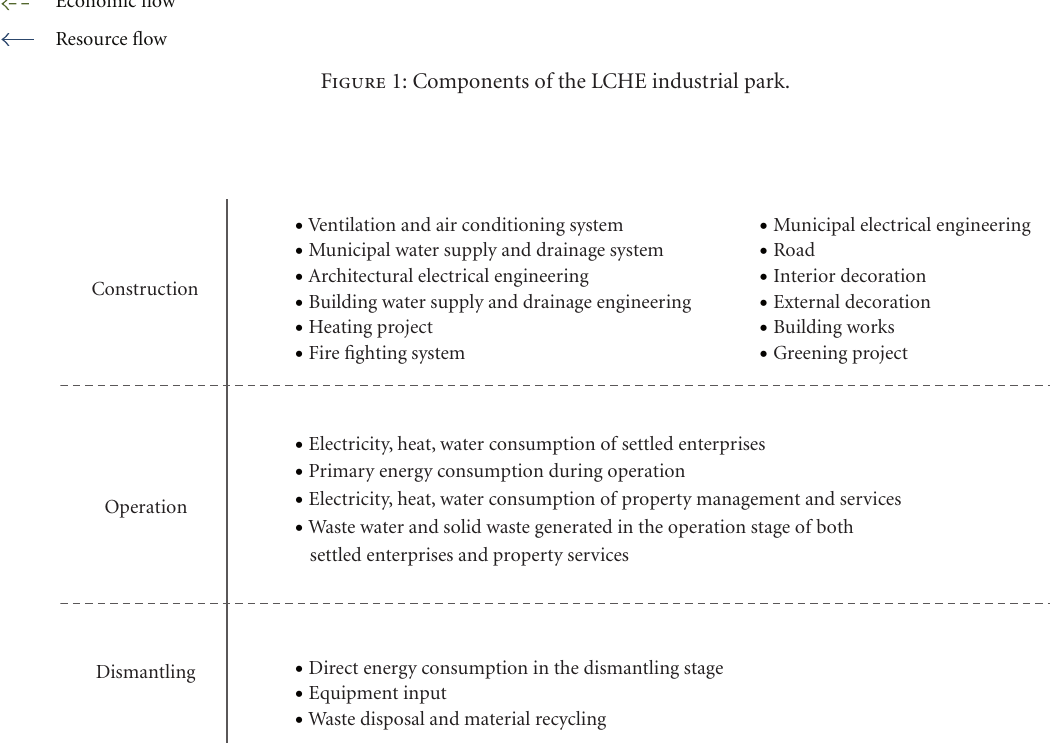
Figure 1: Components of the LCHE industrial park.